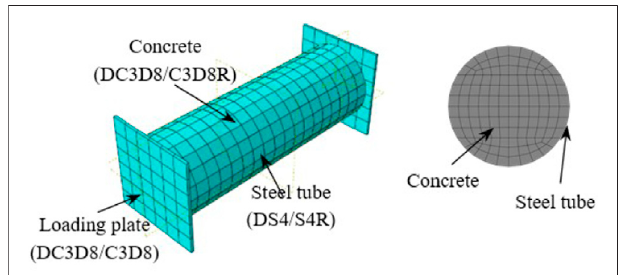
FIGURE 2 | Mesh of the fi nite element